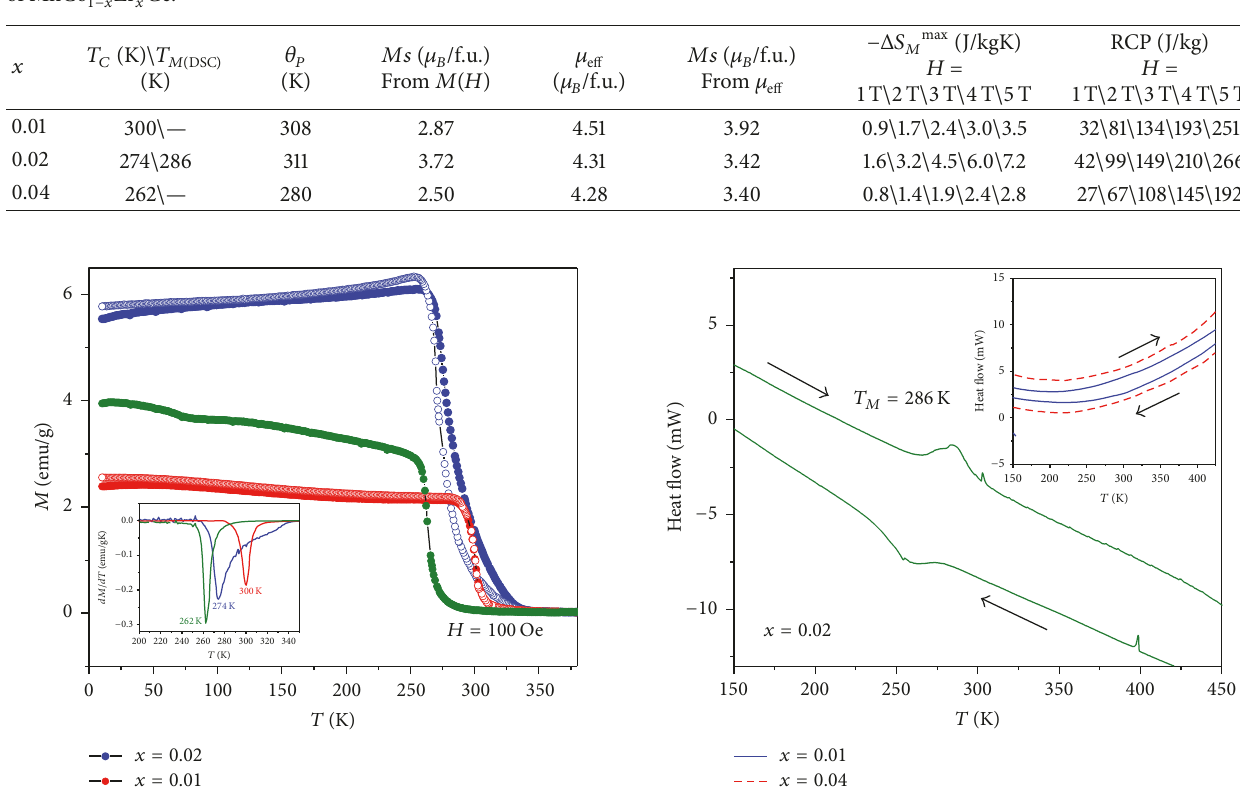
Table 1: Transition temperatures, Curie-Weiss temperatures, saturation magnetization ( 𝑀 𝑆 ), effective magnetic moment, −Δ𝑆 𝑀 max , and RCP of MnCo 1−𝑥 Zr 𝑥 Ge.